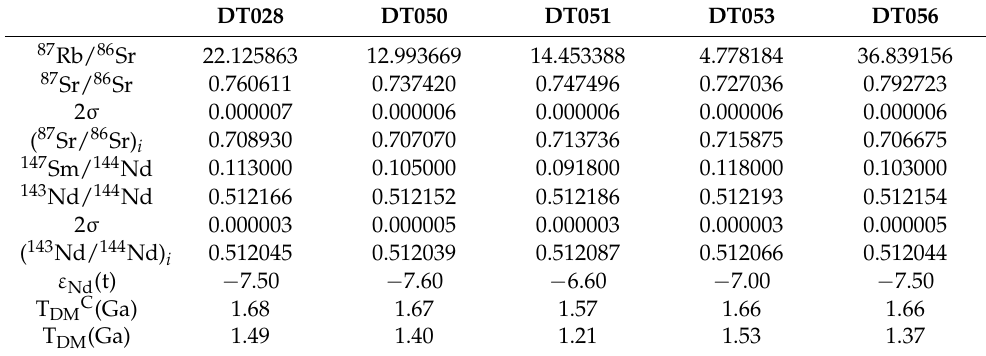
Table 2. Sr–Nd isotope data of the Dongxiang granodiorite